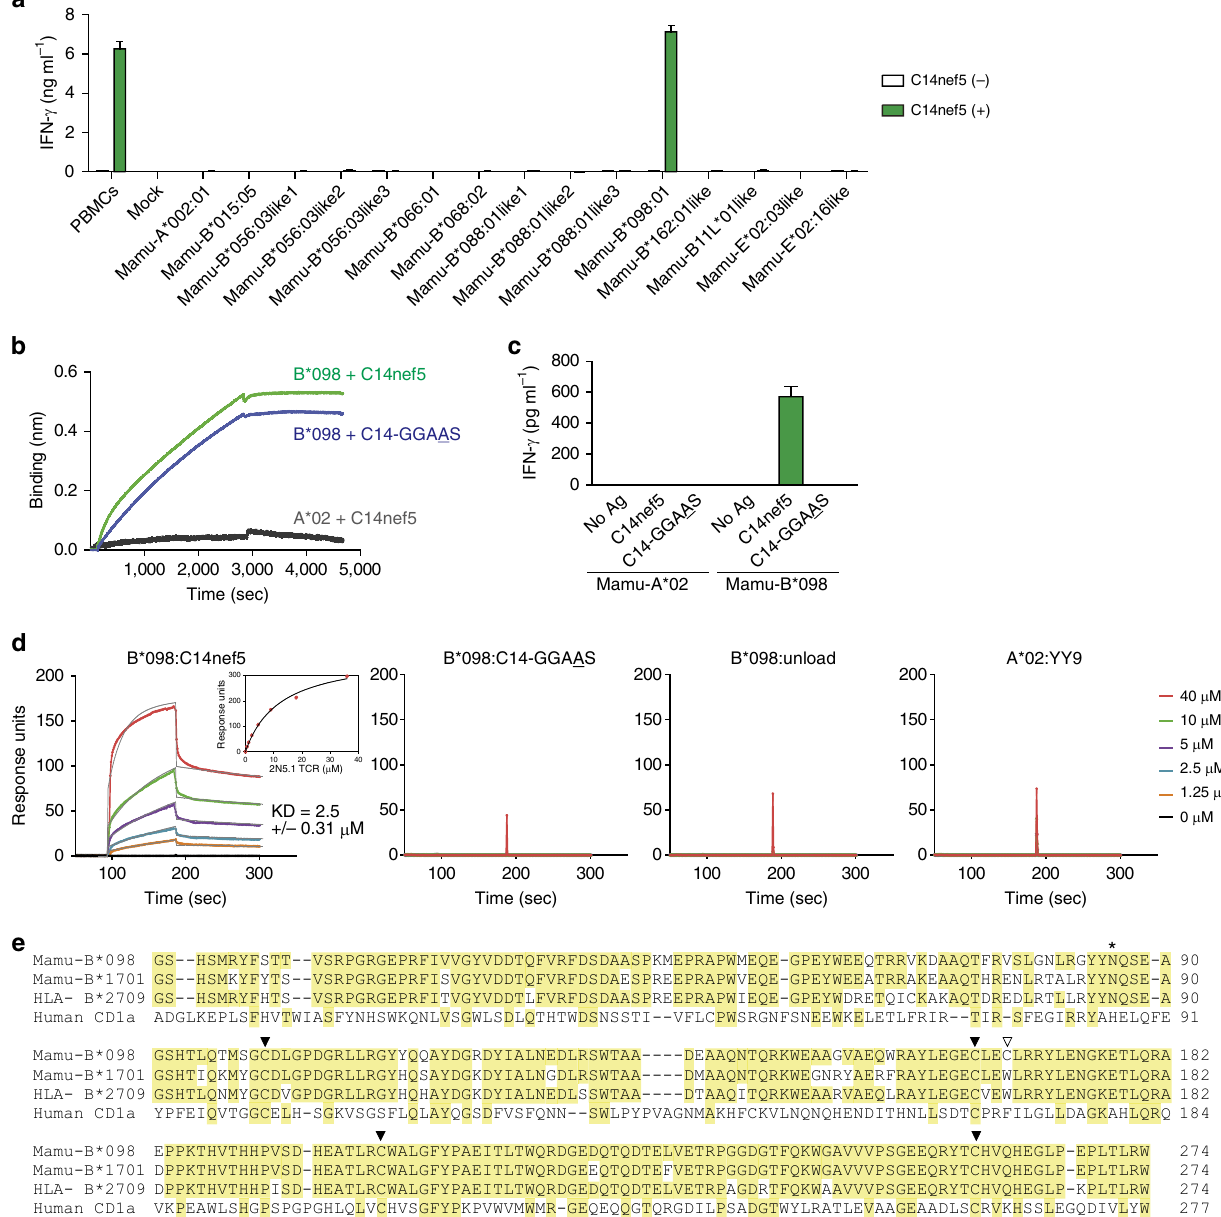
Figure 1 | Identification of Mamu-B*098 as a lipopeptide Ag-presenting molecule. ( a ) LLC-MK2 cells transfected with each of the rhesus MHC class I genes were tested for their ability to present C14nef5 to 2N5.1. Only LLC-MK2 cells expressing Mamu-B*098 stimulated 2N5.1 to produce IFN- g in the presence of C14nef5. PBMCs obtained from a donor with the potential to present C14nef5 to 2N5.1 were used as a positive control. Experiments were performed in triplicate. Mean values with s.e.m. are shown. ( b ) The binding of lipopeptide Ags to recombinant b 2m-linked Mamu-B*098 and Mamu-A*02 proteins was monitored by biolayer interferometry. Representative data from three independent experiments are shown. Mamu-A*02, a rhesus MHC class I allele known to bind 9-mer peptides, was used as a negative control. ( c ) Plate-coated MHC class I molecules were tested for their ability to present lipopeptide Ags to 2N5.1. The Ag-specific T-cell response was assessed by measuring the amount of IFN- g released into the culture medium. Mean values with s.e.m. are shown. ( d ) The high-affinity interaction of the 2N5.1 TCR with C14nef5-loaded Mamu-B*098 was demonstrated by SPR-binding assays, whereas no interaction was detected with C14-GGAAS-loaded and unloaded Mamu-B*098 molecules, as well as YY9 peptide-loaded Mamu-A*02 molecules. The original data (coloured as indicated) are depicted with the curve fit (grey) overlaid. The steady-state affinity plot (inset) is also shown. Three independent experiments were performed and mean equilibrium-dissociation constant ( K D ) values ± s.d. are shown. ( e ) Amino acid sequences of Mamu-B*098, HLA-B*27:09, Mamu-B*17:01 and human CD1a are shown. The a 1 and a 2 domains of Mamu-B*098 exhibit 81.1%, 80.6% and 20.6% sequence homology to the corresponding domains of HLA-B27, Mamu-B*17 and human CD1a, respectively. Solid and open triangles indicate paired and unpaired cysteine residues, respectively. The residue for N-glycosylation is indicated with an (Fig. 1e, shown with an open arrowhead). The introduction of the secondary structure nor the ability of Mamu-B*098 to present cysteine to serine mutation at this position resulted in improved C14nef5 to 2N5.1 (data not shown). Thus, the amino acid refolding efficiency. This mutation affected neither the overall substitution mutant of Mamu-B*098 was used for crystallization.